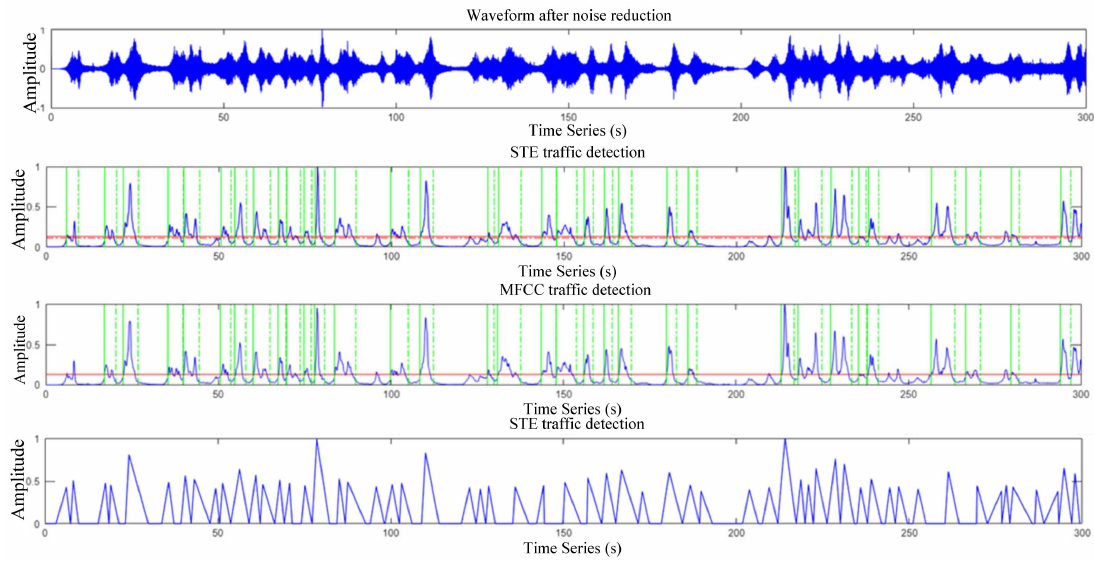
Figure 12. Waveform after noise reduction and three traffic detection characteristic curves.